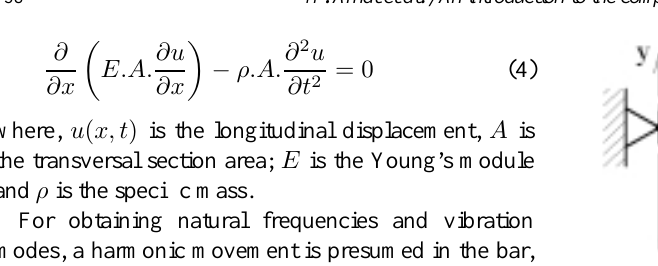
Fig. 5. Uniform straight bar.